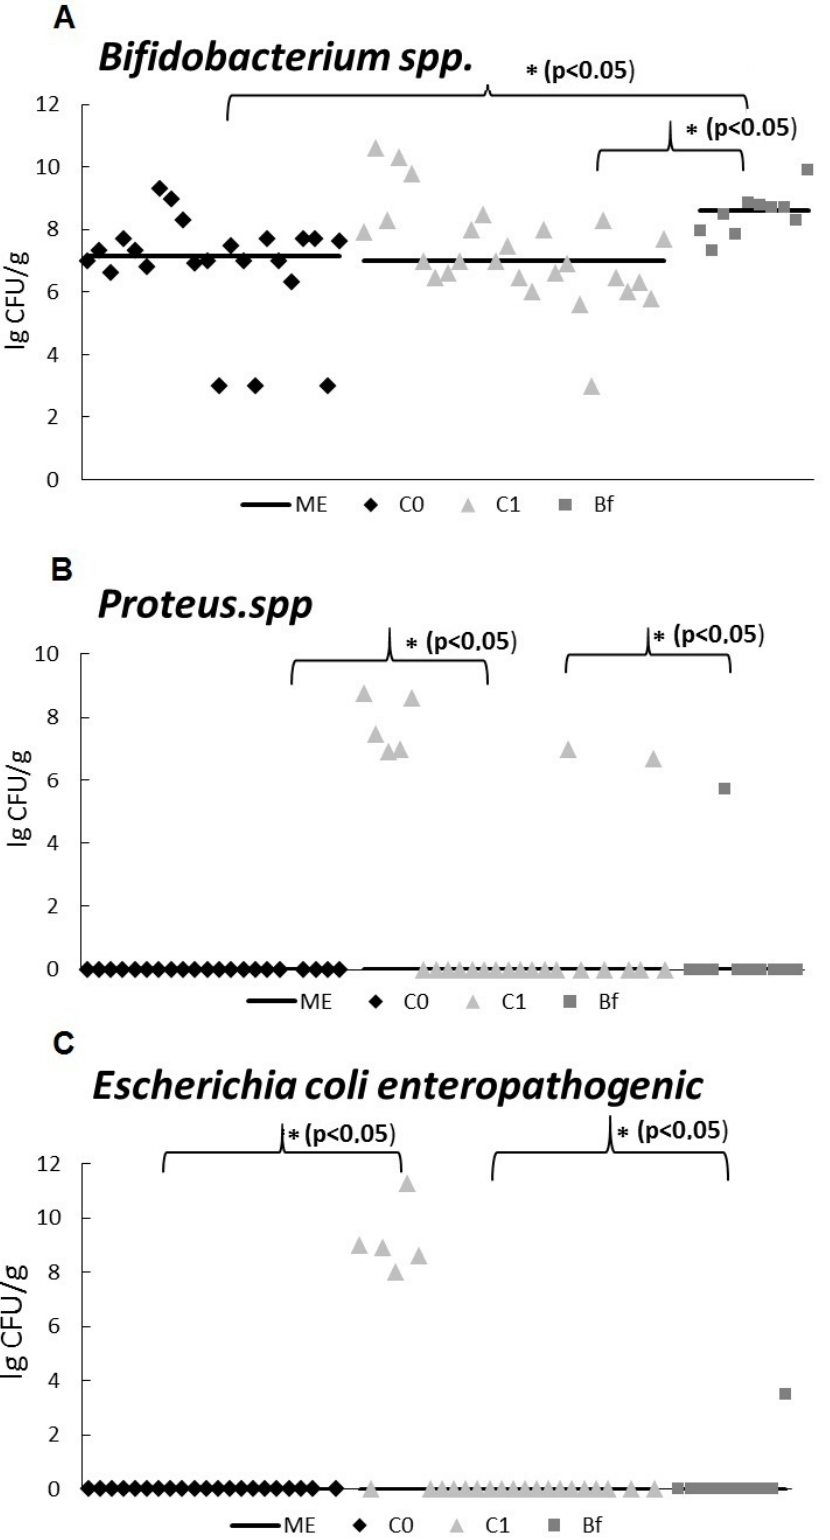
Figure 4. Quantitative content of marker bacteria in the fecal samples in a rat model of antibiotic-associated dysbiosis. The rat groups: C0 (control)—without the introduction of antibiotics and autoprobiotics, C1—without the introduction of autoprobiotics after the withdrawal of antibiotics, Bf—with the introduction of indigenous bifidobacteria after the withdrawal of antibiotics. ( A – C ) ME—median. Mann–Whitney U test, * p <